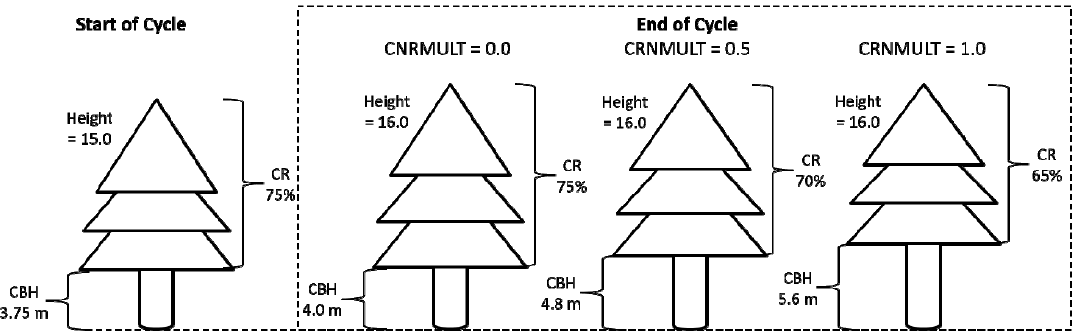
Figure 3. Depiction of how the FVS Crown Change Multiplier Keyword (CRNMULT) influences crown base height recession. This scenario shows a tree growing 1 m in height with FVS predicting a 10% reduction in crown ratio during one FVS cycle (10 years). The end of cycle outputs is set to correspond to CRNMULT values of 0.0, 0.5, and 1.0 (default) as you go from left to right respectively. In this scenario the CRNMULT values result in 0%, 5%, and 10% reductions in crown ratio as you go from left to right, with each having a slightly different effect on crown base height (CBH).